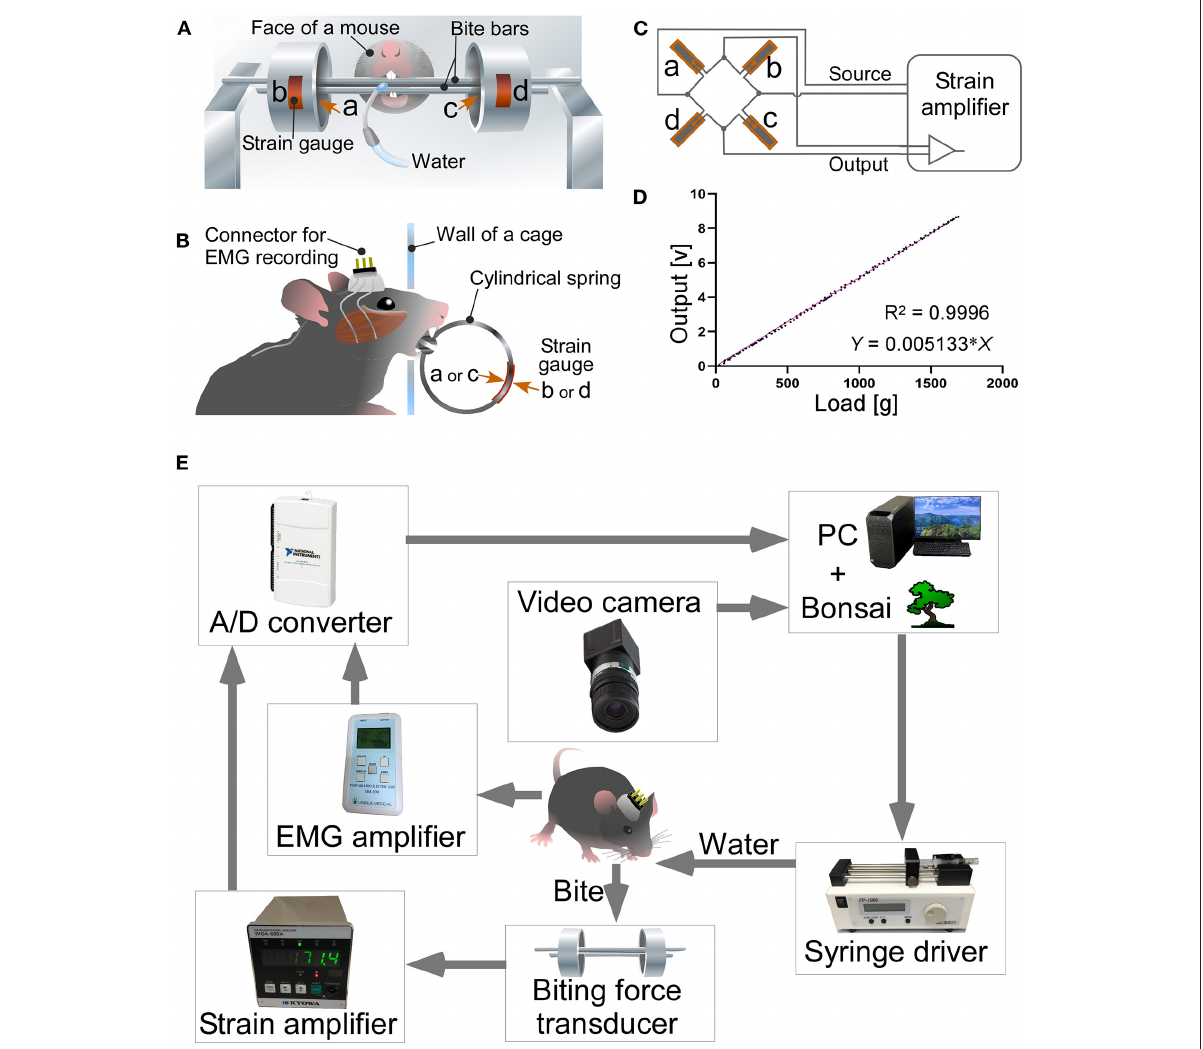
FIGURE1 A bite force measurement apparatus and a system for simultaneous measurement of bite force and EMG. Front (A) and side views (B) of a bite force transducer. Strain gauges (b,d) were pasted on the outer surface of each cylindrical spring, while others (a,c) were placed on the inner surface. The wall of the recording cage has a hole of 1.5cm in diameter. Mice faced through the hole, chewed bite bars, and drank the rewarding water. (C) A full bridge was constructed with four strain gages and connected to the strain amplifier. (D) Relationship between load and voltage output of the bite force transducer. (E) A system for simultaneous measurement of bite force and EMG. See text for further details.